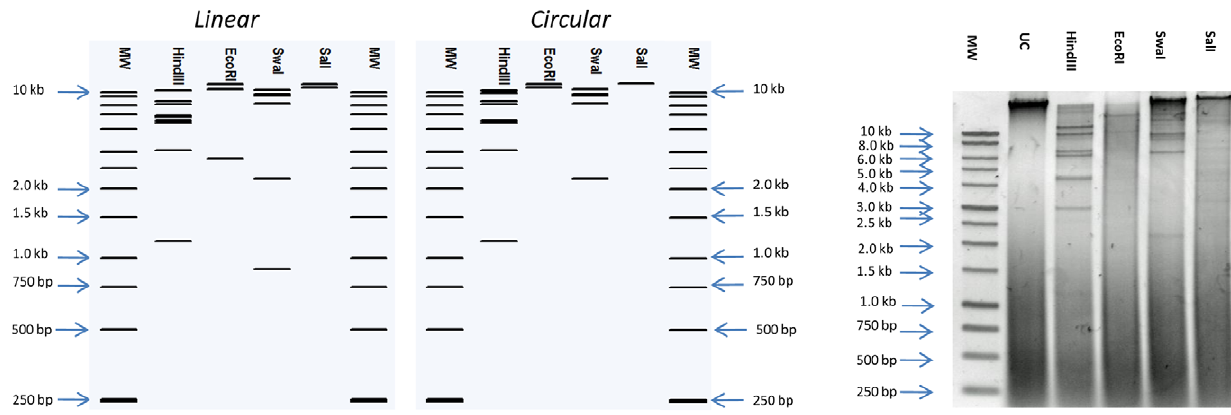
Figure 3. Physical structure of w B124-14 genome. Left and middle panels show in silico digest and electrophoresis to visualise restriction fragment profiles of w B124-14 expected for each permutation of the genome (linear or circular) generated by pDRAW32. Right panel shows results obtained from digestion of 1.5 m g of w B124-14 DNA (3 h at 37 u C) with restriction enzymes used in in silico analysis. Restriction enzymes tested are indicated above each lane. MW =1 kb Molecular Weight marker (Promega). UC = uncut w B124-14 DNA.